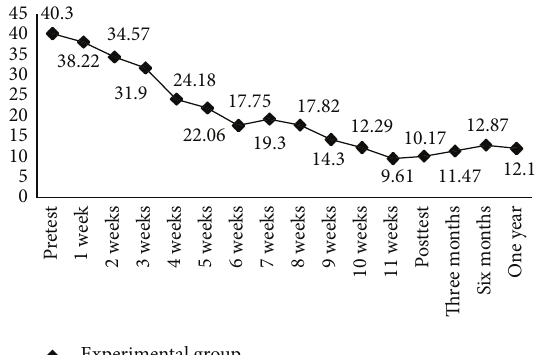
Figure 2: Changes in BDI-II scores at the various follow-up assessments.